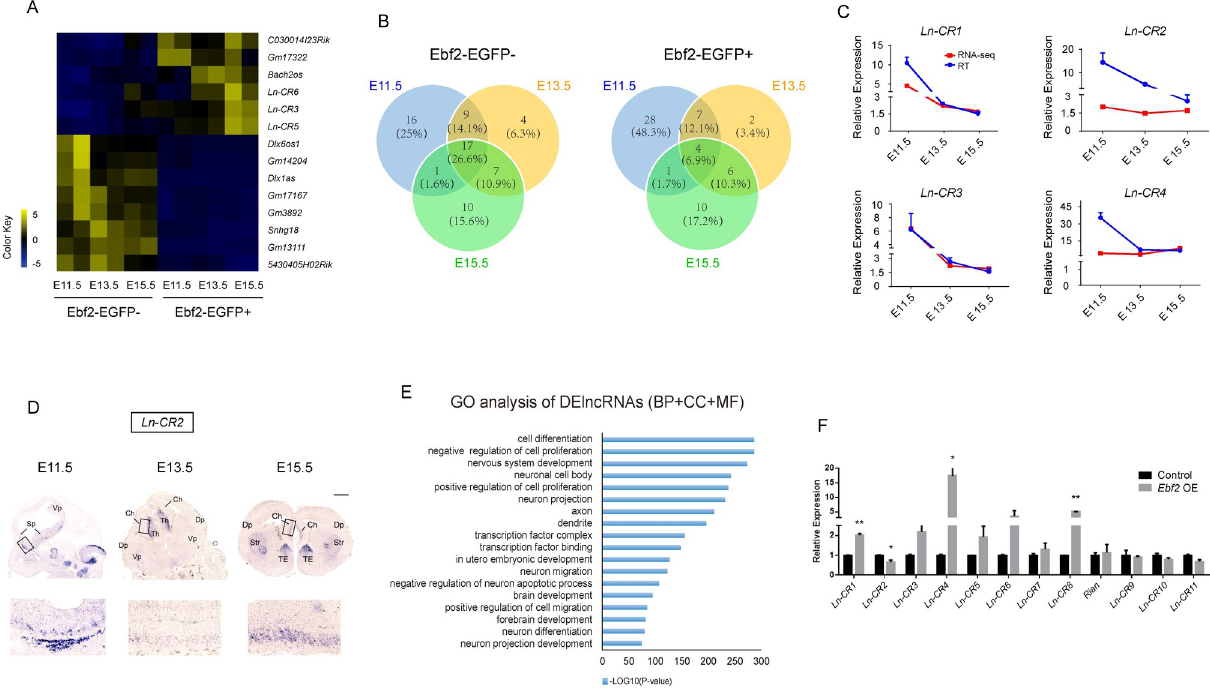
Fig 3. Characterization of differentially expressed lncRNAs in the Ebf2-EGFP+ and Ebf2-EGFP- cells. (A) Heatmap representing all differential expressed lncRNAs (FDR < 0.05, p-value < 0.05) in Ebf2-EGFP+ & Ebf2-EGFP- cell samples at the three embryonic stages. (B) Venn diagram displaying the extent of overlapping between DElncRNAs at the three embryonic stages. (C) The expression pattern of DElncRNAs between Ebf2-EGFP+ or Ebf2-EGFP- cells is consistent revealed by RNA-seq and qRT-PCR. Data represent mean ± SEM (n = 3 independent experiments). (D) In situ hybridization showing the endogenous expression of CR-specific lncRNA Ln-CR2 at E11.5, E13.5 and E15.5, respectively. Regions with specific expression are labeled and higher magnification images of boxed areas are shown below. Abbreviations: Sp, septum; Vp, ventral pallium; Th, thalamus; Dp, dorsal pallium; Ch, cortical hem; Str, striatum; TE, thalamus eminence. Scale bar, 900 μ m. (E) Enriched functional assessments (including biological processes, cellular components and molecular function) of highly expressed DElncRNAs (fold change � 2) in Ebf2-EGFP+ or Ebf2-EGFP- cell population. (F) qRT-PCR analysis comparing the expression levels of lncRNAs in primary neural cell culture assay after virus infection with control (H1) or Ebf2 -overexpression. Data represent mean ± SEM (n = 4 independent experiments, � P < 0.05, Student’s T test).